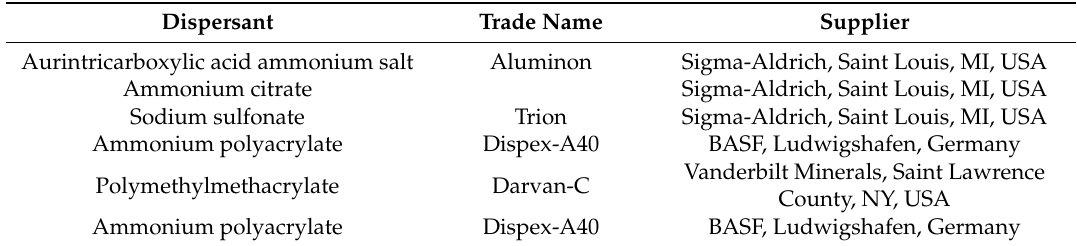
Table 8. Electrostatic Dispersants for Inkjet printing.